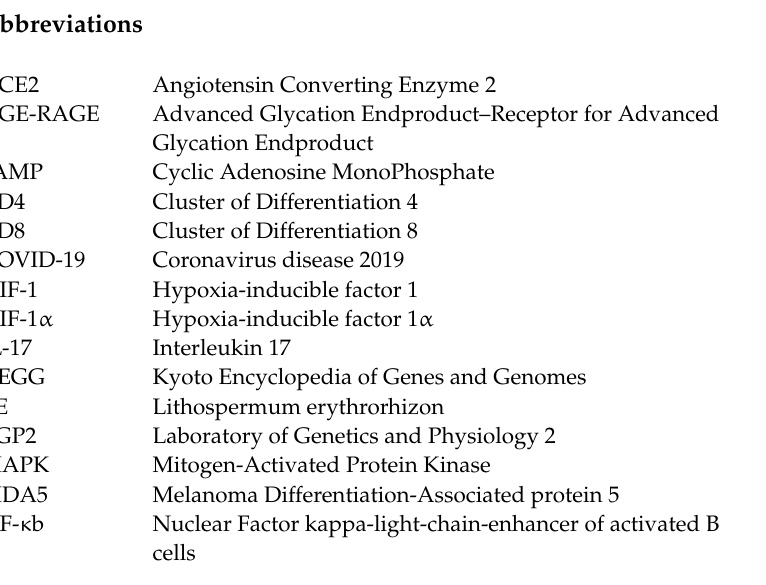
SEA and STP: 249 targets. Table S3: COVID 19-related targets: 356 targets. Table S4: The final 19 overlapping targets related to